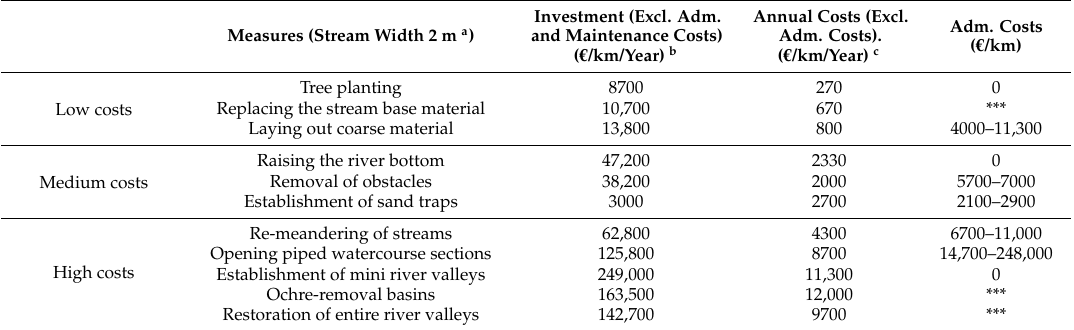
Table 3. Comparison of the investment costs and the annual costs of the selected measures (modified after